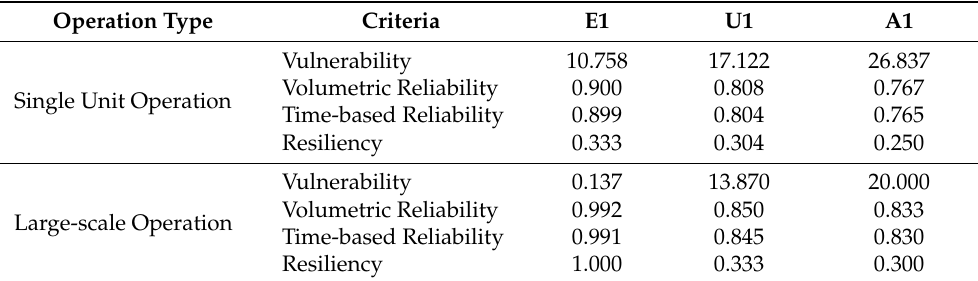
Table 4. Risk-based criteria for the Bukan dam without and under the effect of